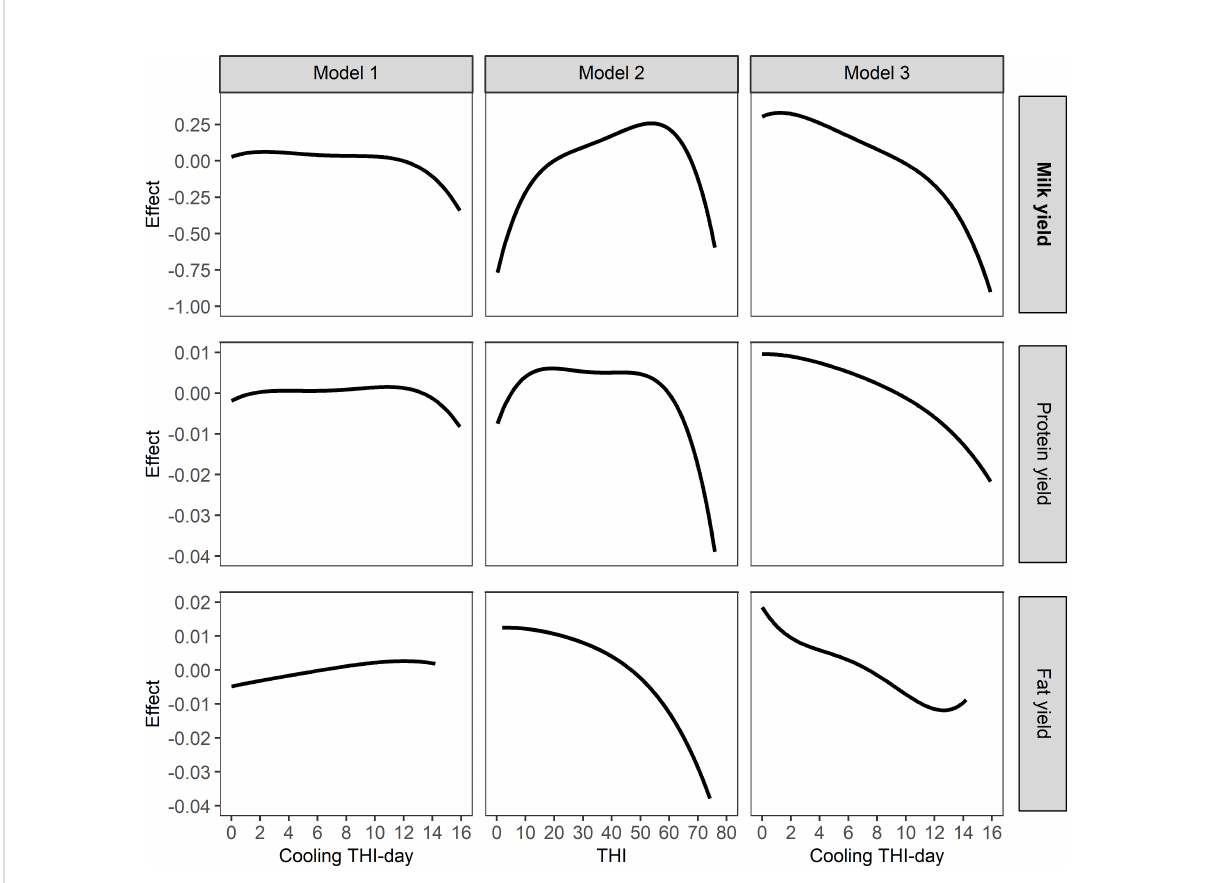
FIGURE 3 Reaction of average milk yield (top), protein yield (middle), and fat yield (bottom) to THI and cooling THI-day full model (left; plot is for cooling THI-day), THI (middle), and cooling THI-day